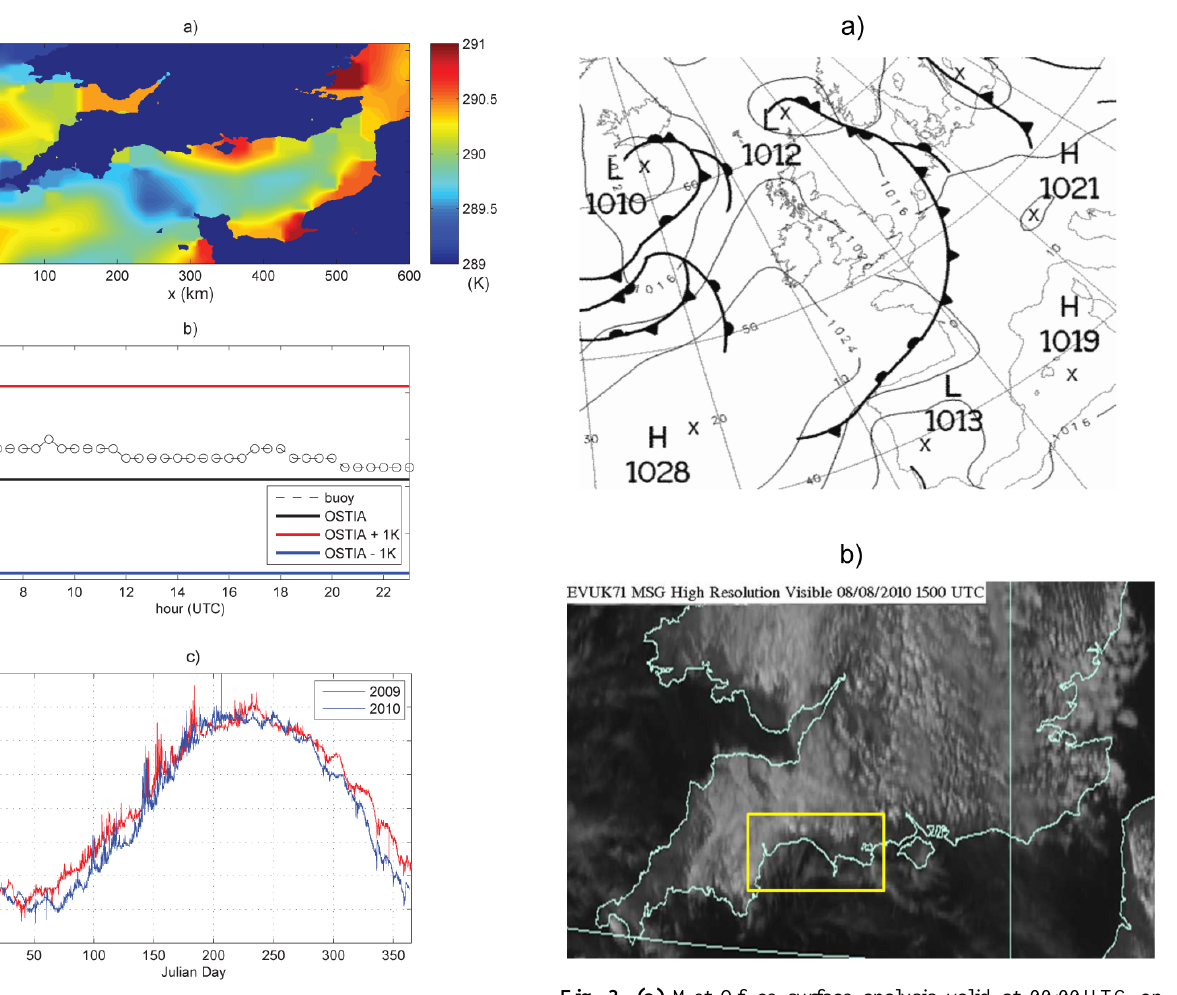
Fig. 2. (a) OSTIA SST in the 1km MetUM domain. (b) Observed SST from the Weymouth waverider buoy (black circles) and SST used in simulations (solid lines) as a function of time on the day of the case study. (c) Observed SST during the years 2009 and 2010 from the Weymouth waverider buoy. (Waverider buoy data supplied by the Channel Coastal Observatory.)